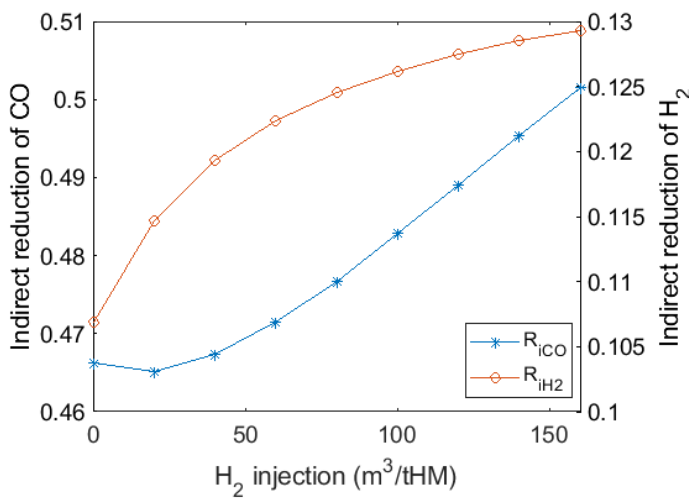
Figure 10. Variations in degree of indirect reduction by CO and H 2 with H 2 injection and thermal compensation.